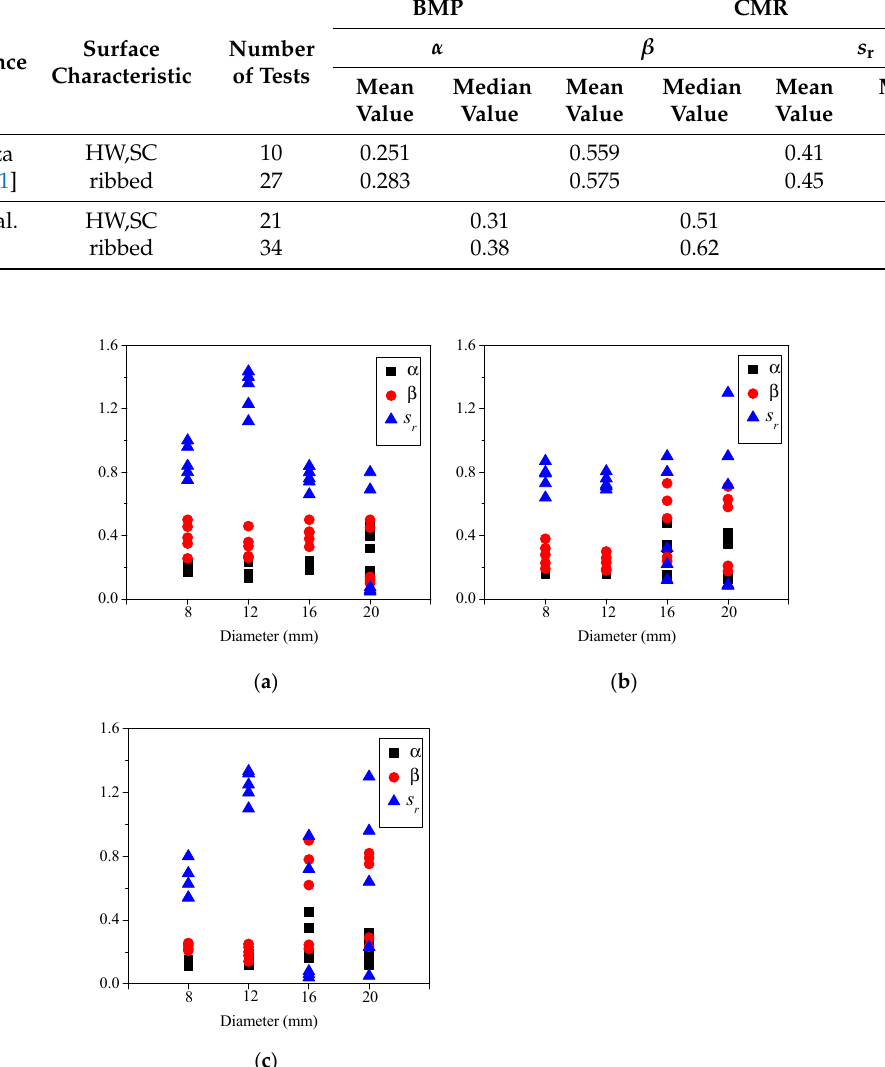
Figure 14. Distribution of fitting parameters α β s r based on surface characteristics ( a ) R1/HW; ( b ) R2/ HW, SC; and,( c ) R3/Ribbed.